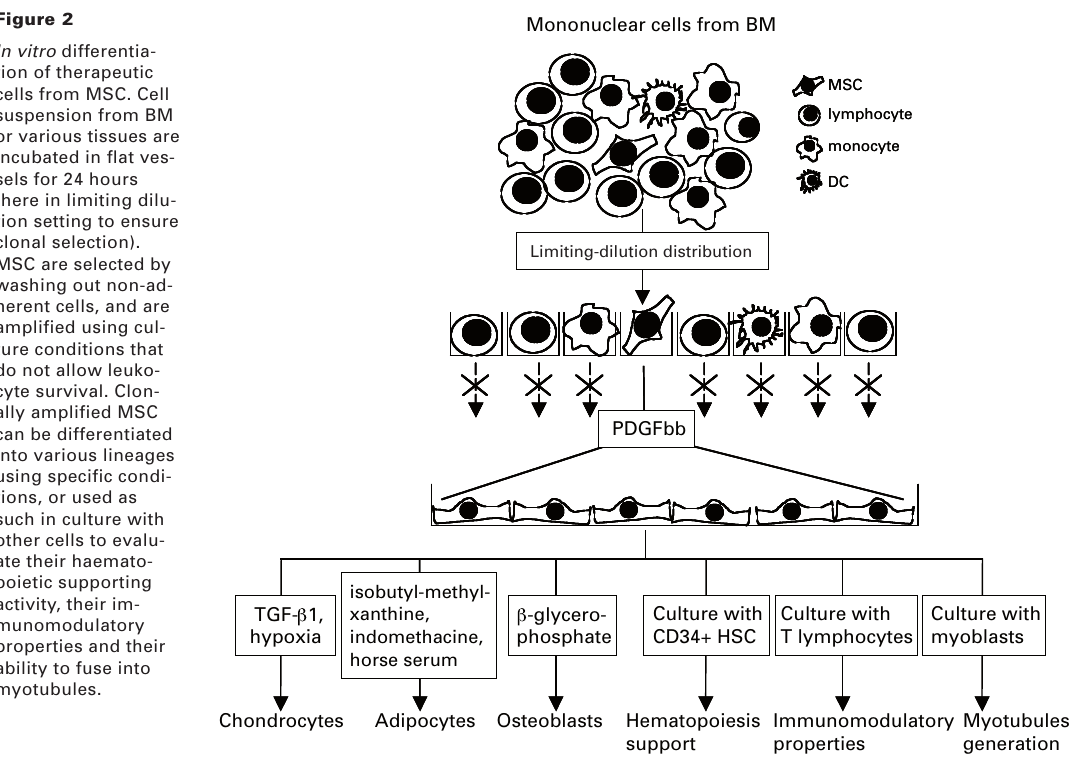
In vitrodifferentia- tion of therapeutic cells from MSC. Cell suspension from BM or various tissues are incubated in flat ves- sels for 24 hours (here in limiting dilu- tion setting to ensure clonal selection). MSC are selected by washing out non-ad- herent cells, and are amplified using cul- ture conditions that do not allow leuko- cyte survival. Clon- ally amplified MSC can be differentiated into various lineages using specific condi- tions, or used as such in culture with other cells to evalu- ate their haemato- poietic supporting activity, their im- munomodulatory properties and their ability to fuse into